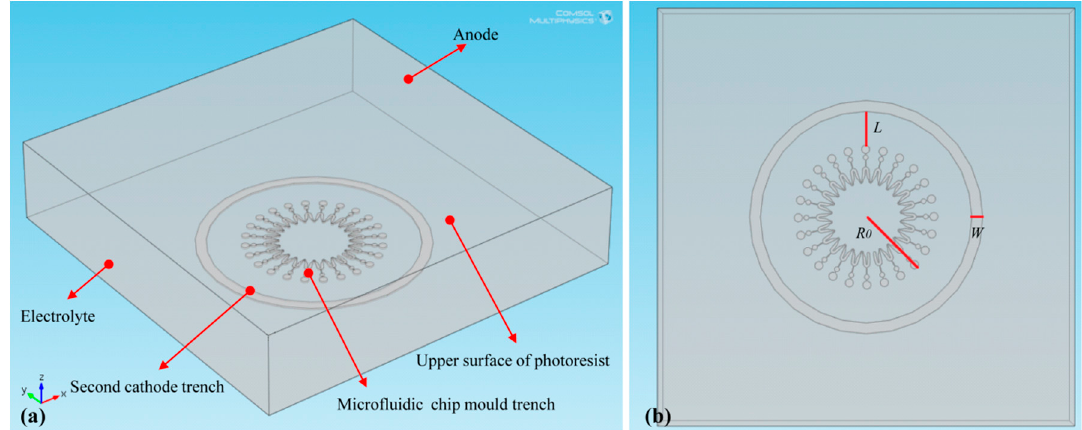
Figure 2. Electroforming geometric model. ( a ) pictorial drawing, ( b ) top view.